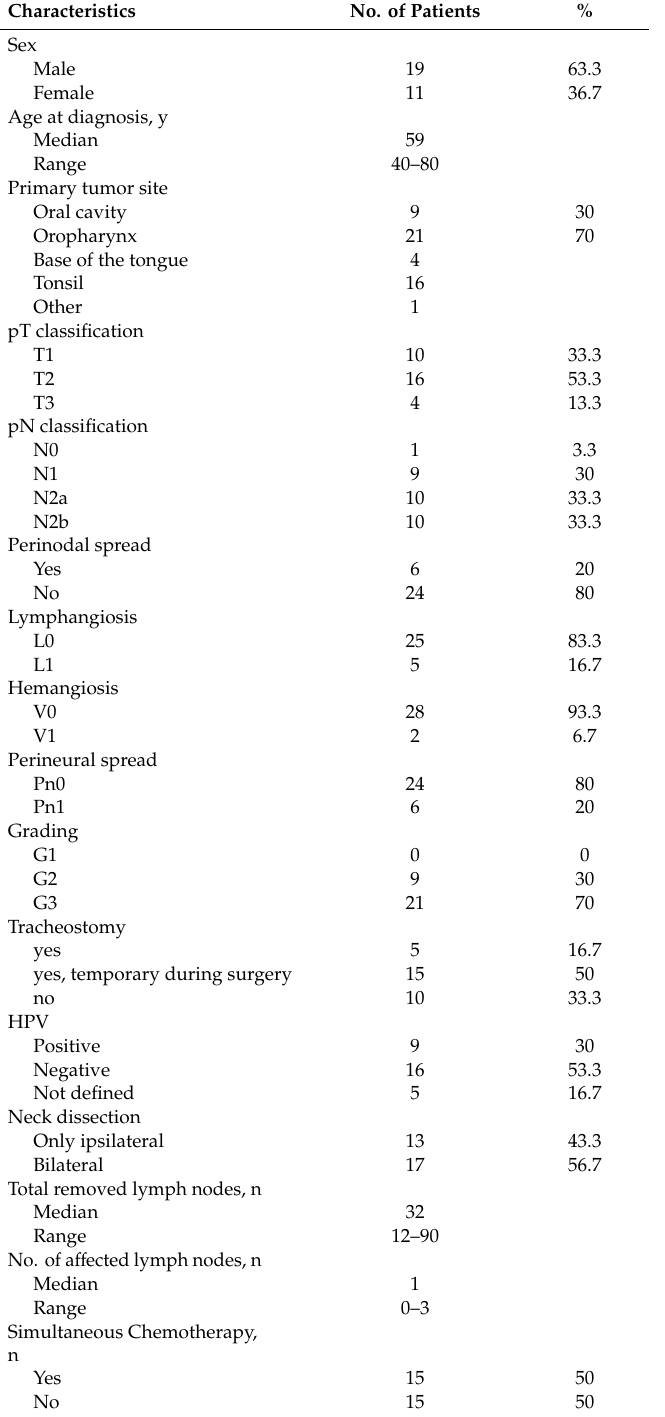
Table 1. Patient